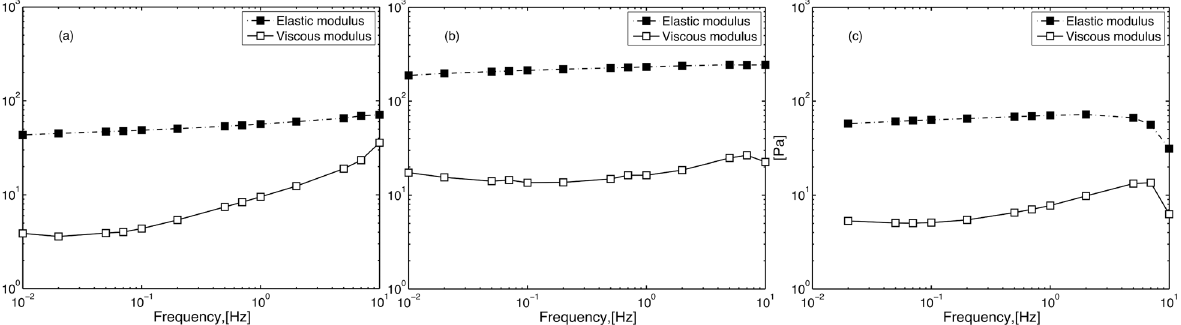
Fig 1. Oscillation measurements at constant stress (1 Pa) of 1 wt% polymer gels in water at pH 6. From left to right Carbopol 981 (a), Pemulen TR 1 (b) and Pemulen TR 2 (c). The elastic (G ’ , filled squares) and viscous (G ” , open squares) moduli are shown as functions of frequency.